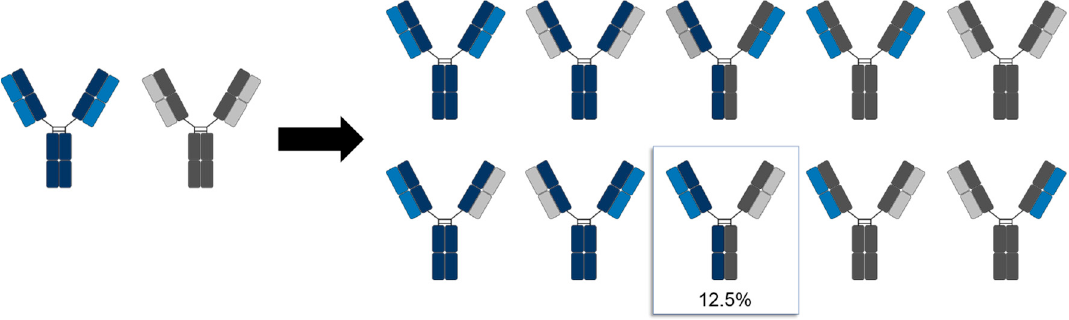
Figure 1. Schematic illustration of the bsAb chain association issue. Upon co-transfection of a host-cell with plasmids encoding for two different heavy and two different light chains, ten unique chain pairings can occur. The desired bsAb will appear with a statistical probability of 12.5%.